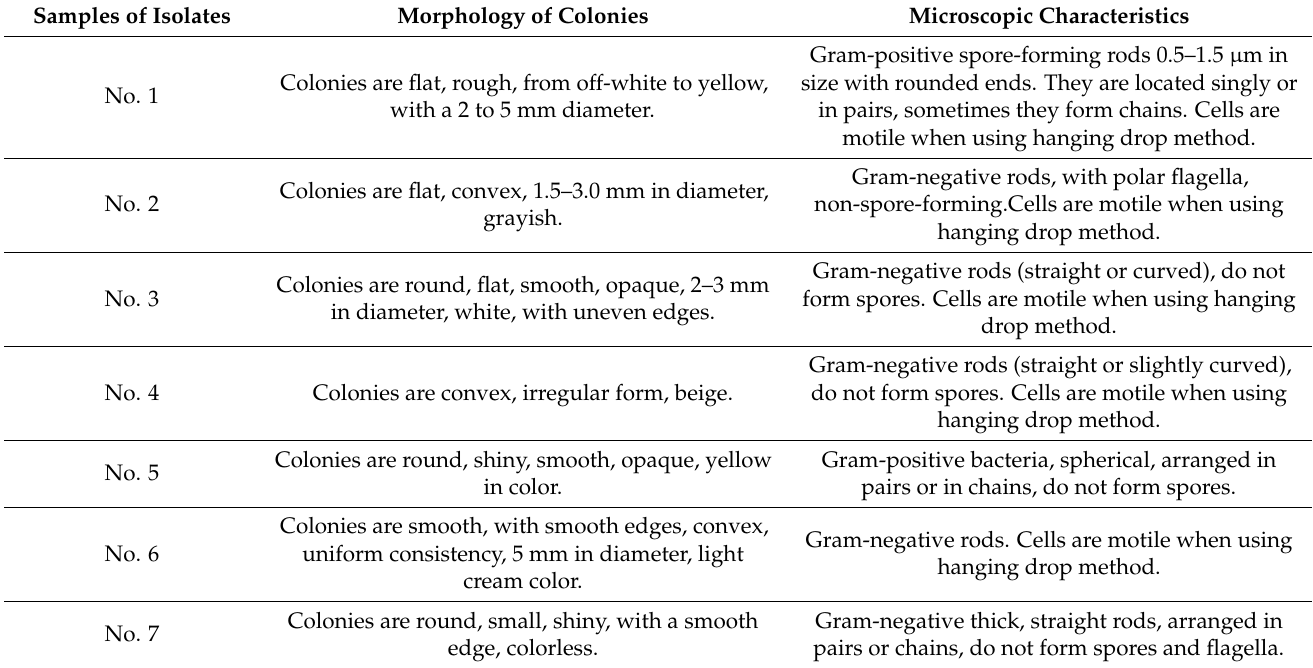
Table A1. The Cultural and Morphological Properties of Isolates from the Bottom Sediments of Baikal Lake. Samples of Isolates Morphology of Colonies Microscopic Characteristics Gram-positive spore-forming rods 0.5–1.5 µ m in Colonies are flat, rough, from off-white to yellow, size with rounded ends. They are located singly or No. 1 with a 2 to 5 mm diameter. in pairs, sometimes they form chains. Cells are motile when using hanging drop method. Gram-negative rods, with polar flagella, non-spore-forming.Cells are motile when using grayish. hanging drop